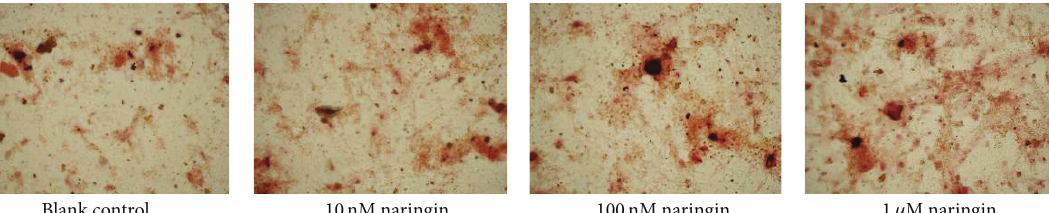
Figure 7: The image of mineralized deposits.